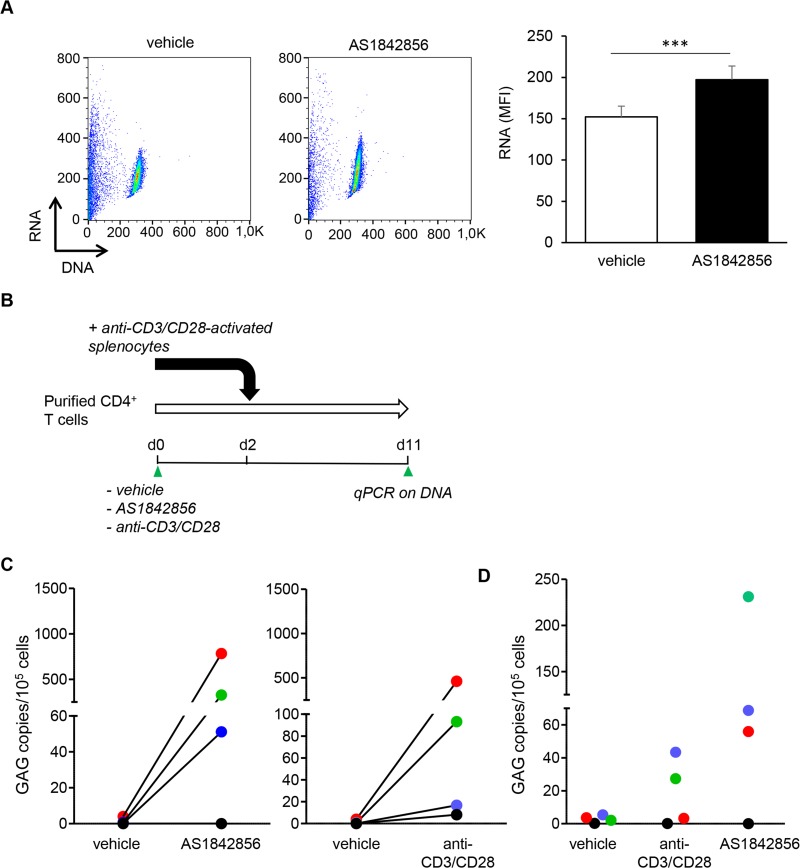
AS1842856 allows latent provirus reactivation ex vivo.(A) PBT purified from healthy macaques were cultured for 7 days in the presence of AS1842856 (500nM) or vehicle only. RNA and DNA cell content were measured by FACS on the gated cells after acridine orange staining. Results obtained with one representative macaque (left panel) and mean results +/- SE with T cells from 3 independent animals (right panel) are shown. (B) Experimental design. CD4+ T cells from animals infected with SIV mac251, and treated for 6 months with antiretroviral agents (Tenofovir, Emtricitabine, Dolutegravir), were cultured for two days with AS1842856 (500nM), vehicle only or anti-CD3/CD28 coated beads, used here as positive control. Heterologous simian splenocytes from non-infected animals stimulated for three days with anti-CD3/CD28 beads were then added. Measurements by quantitative PCR of Gag sequence in genomic DNA were performed nine days later. (C) Results obtained with four animals, each represented by a distinct color symbol, are shown. (D) Supernatants harvested at the end of the above assays were ultracentrifugated and concentrated viruses added to 106 heterologous splenocytes from non-infected monkey preactivated with anti-CD3/CD28 beads. After 5 days of culture, cells were harvested and infection levels were measured by Gag sequence quantification in genomic DNA. The same color code than in panel C was used for each animal.